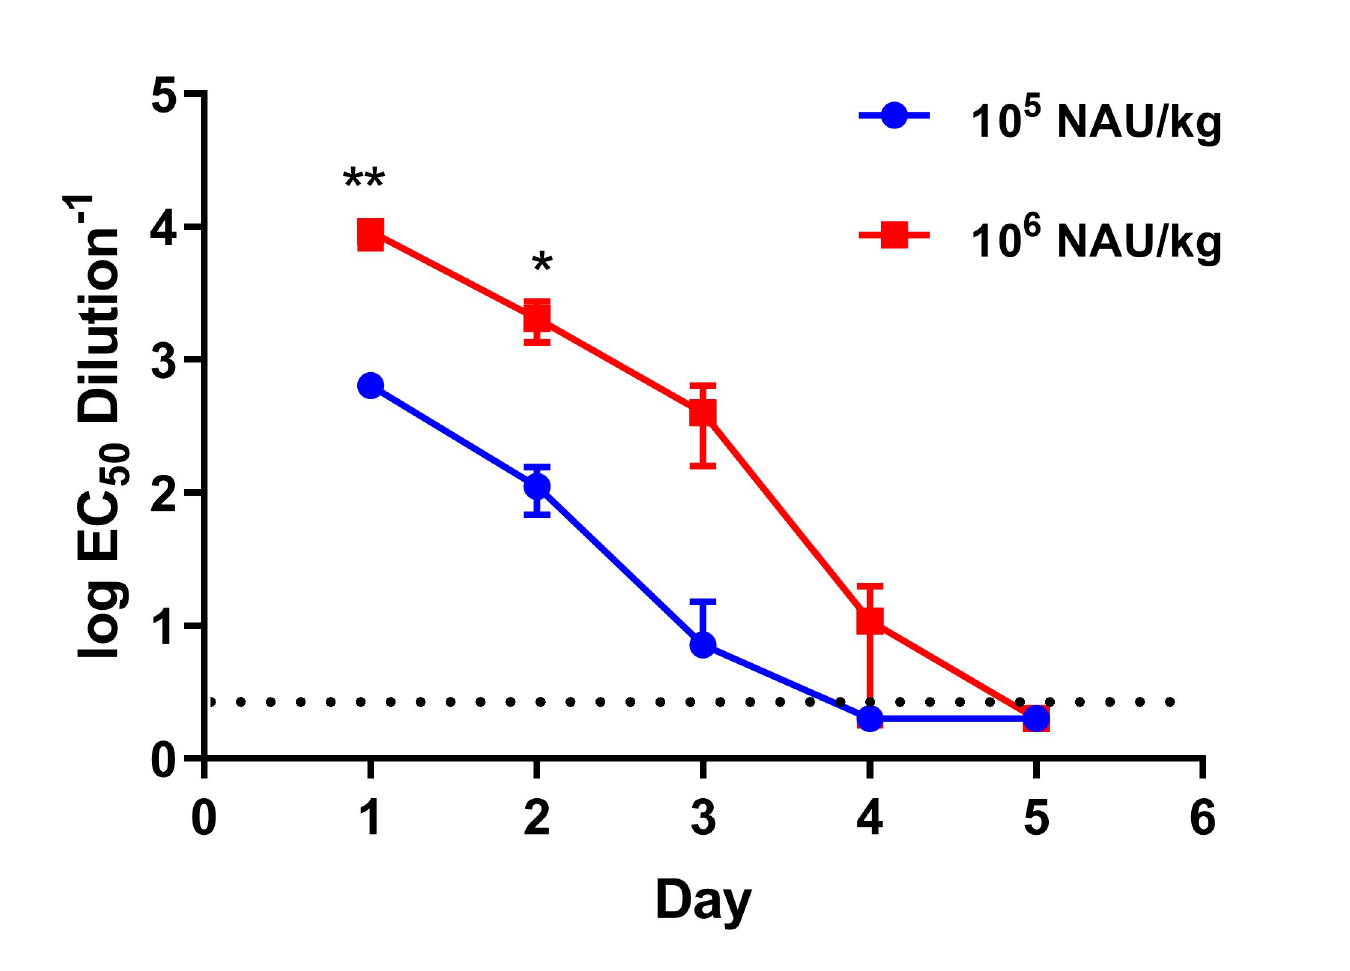
Fig 5. Bioavailability of anti-EBOV IgY in guinea pigs. Two Groups of guinea pigs (12-week-old, n = 3 per group) were injected s.c. with 10 6 NAU/kg or 10 5 NAU/kg IgY. Sera NAb titers were tested daily by VSV-PsN assay. A two-way ANOVA with Tukey’s multiple-comparison tests were performed to analyse statistically significant differences between the two different dose groups. Significant differences were observed at 1and 2 days post-injection ( � P < 0.05; �� P < 0.01). The dashed line in e indicates the detection limit. Data are shown as means ± SEM.